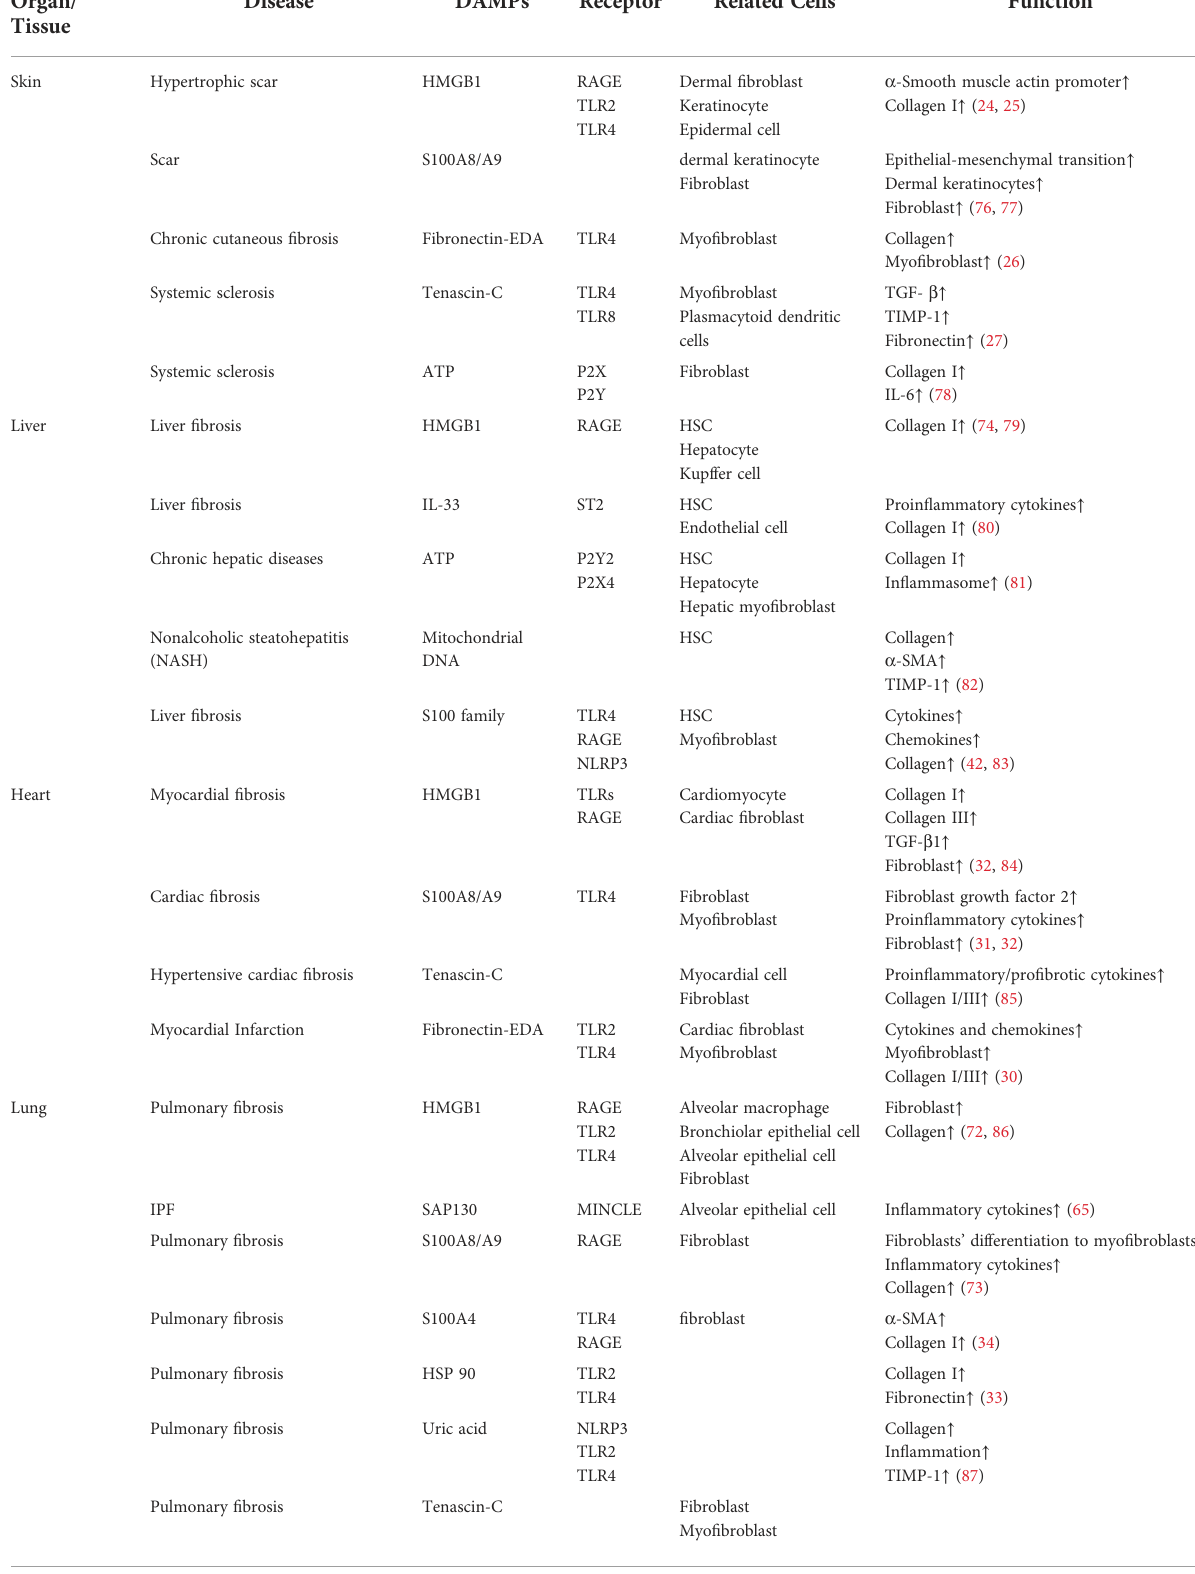
TABLE 1 Functions of necroptotic DAMPs and their receptors in fi brosis. Organ/